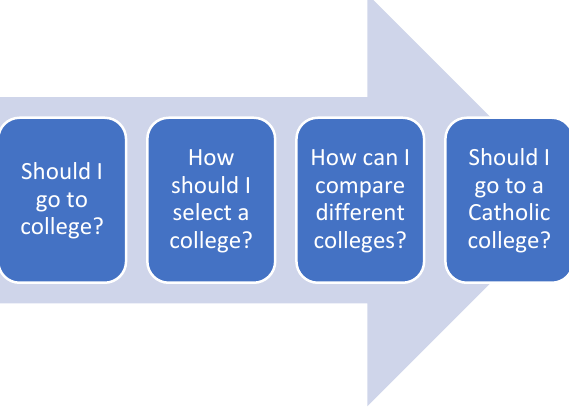
Figure 1. Four Basic Sequential Questions. Source: Author.